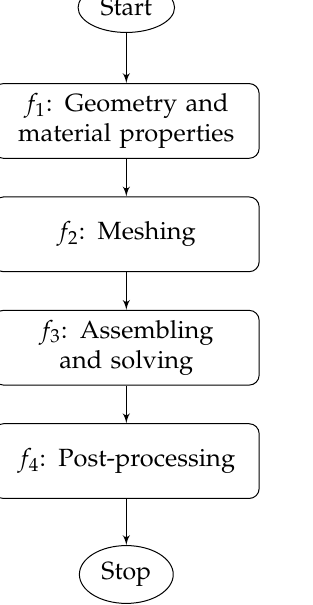
Figure 9. Conventional structure of a finite element